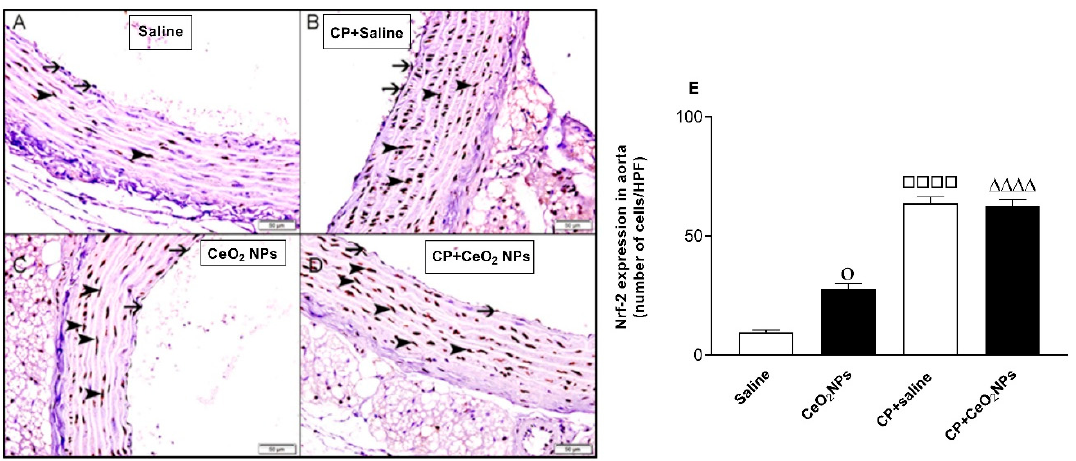
Figure 3. ( A – E ): Immunohistochemical analysis of the aortic tissue sections for the detection of nuclear factor erythroid-derived 2-like 2 (Nrf2) in rats intratracheally instilled with either saline (control) or cerium oxide nanoparticles (CeO 2 NPs) with or without cisplatin (CP) administration. ( A ) Representative section of the aorta of saline-treated rats showing normal aorta with nuclear staining of a few endocardial cells and smooth muscles with Nrf2. ( B ) Representative section of the aorta of rats treated with CP and intratracheally instilled with saline showing increased number of nuclei of smooth muscles and endocardial cells stained with Nrf2. ( C ) Representative section of the aorta of CeO 2 NPs-treated rats showing increased number of nuclei of smooth muscles and endocardial cells stained with Nrf2. ( D ) Representative section of the aorta of rats treated with CP and intratracheally instilled with CeO 2 NPs showing increased number of nuclei of smooth muscles and endocardial cells stained with Nrf2. ( E ) Quantification of the numbers of nuclei of smooth muscles and endocardial cells stained with Nrf2 per high power field (HPF) in rats intratracheally instilled with either saline ( n = 6) or CeO 2 NPs ( n = 6) with ( n = 6) or without ( n = 6) CP administration. ΔΔΔΔ P < 0.0001 compared with CeO 2 NPs-treated group. □□□□ P < 0.0001 compared with saline-treated group. ο P < 0.05 compared with saline-treated group. Data are mean ± SEM.